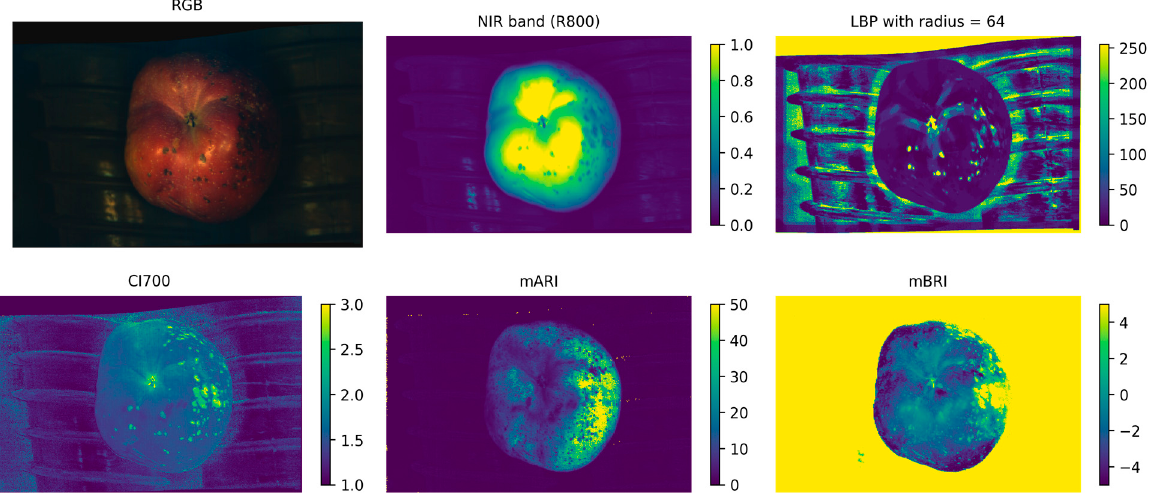
Figure 3. Visual representation of some of the features (indicated above the figures) used for the classification of sound and damaged fruit regions (see also Methods).